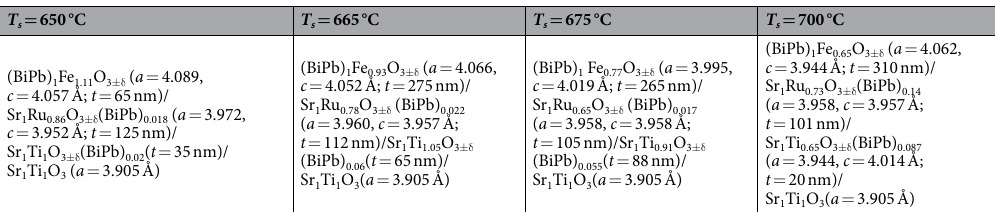
Table 1. Composition and thickness ( t ) of each layers of (BiPb)FeO 3 /SrRuO 3 /SrTiO 3 hetero-structures deduced from simulated RBS spectra at different T g . Lattices parameters ( a and c ) estimated by RSM are also given in the